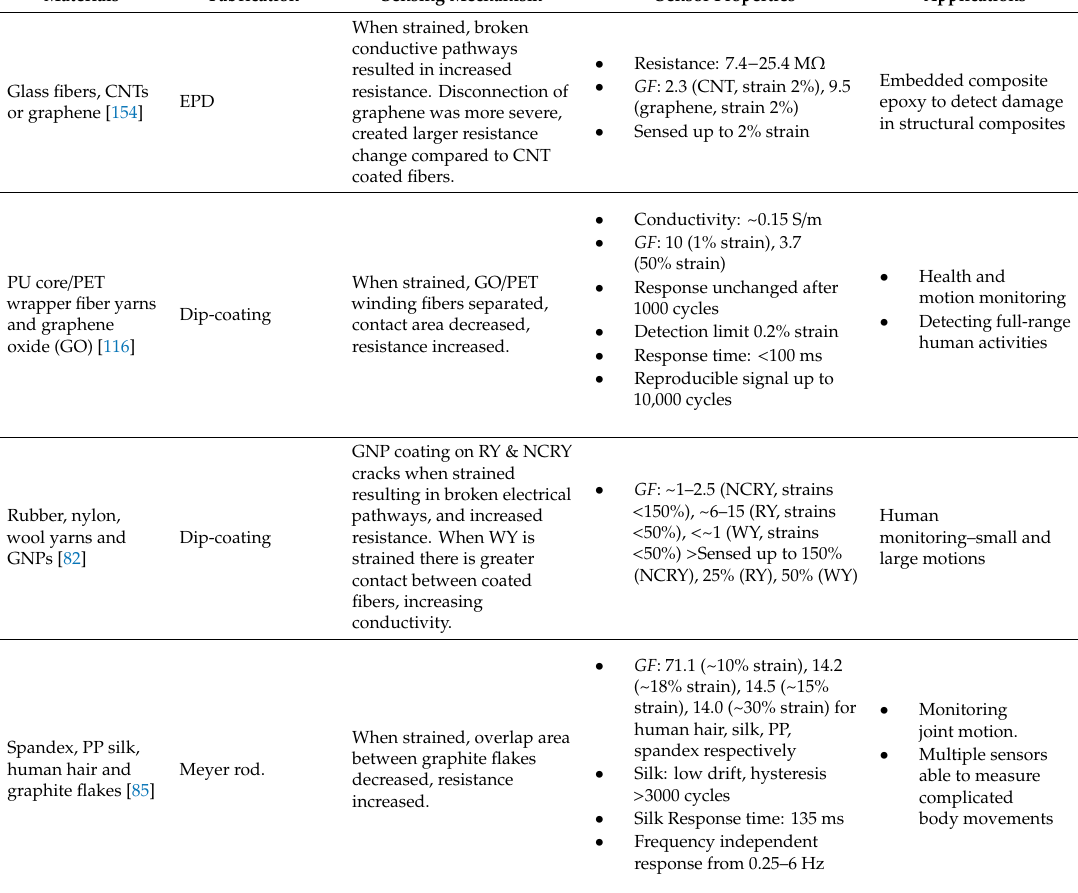
Table 3. Fiber-based strain sensors coated with